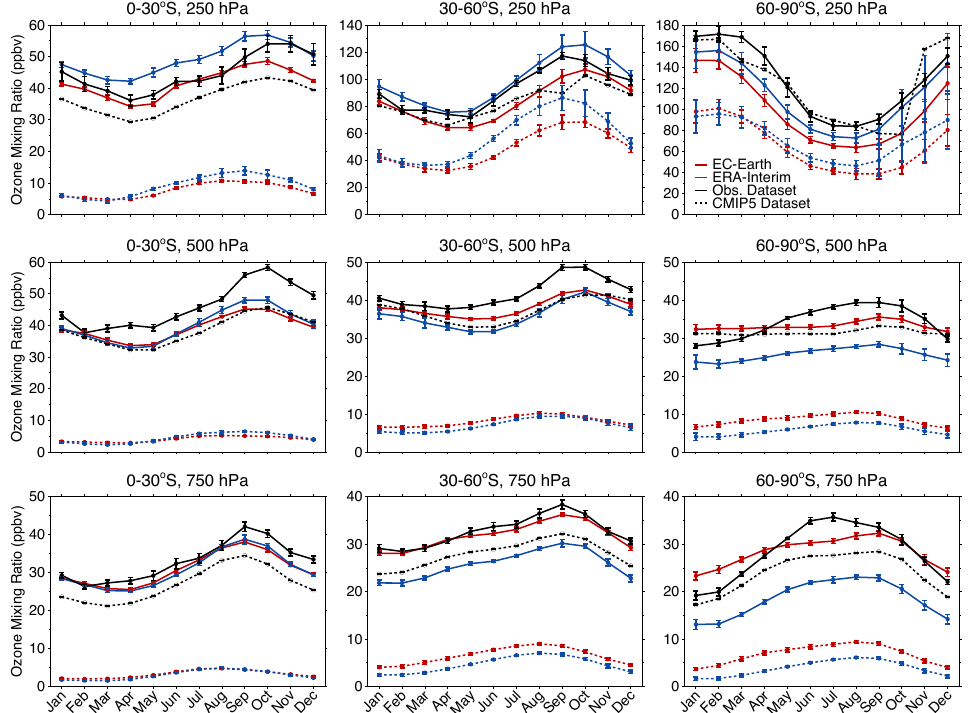
Figure 8. Monthly mean O 3 mixing ratios at 750, 500, and 250hPa averaged over different latitude bands in the SH. The results from the reference EC-Earth simulation (solid red lines) and the corresponding ERA-Interim simulation (solid blue lines) are compared against the observational data set (solid black lines) constructed from the Binary Database of Profiles (BDBP). The CMIP5 data set from Cionni et al. (2011) is indicated by the dashed black lines. The contributions from O 3S for the EC-Earth and ERA-Interim simulations are shown by the dashed red and blue lines,